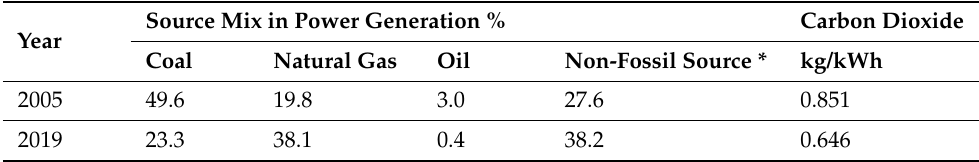
Table 4. Carbon dioxide emissions in the power generation sector of the